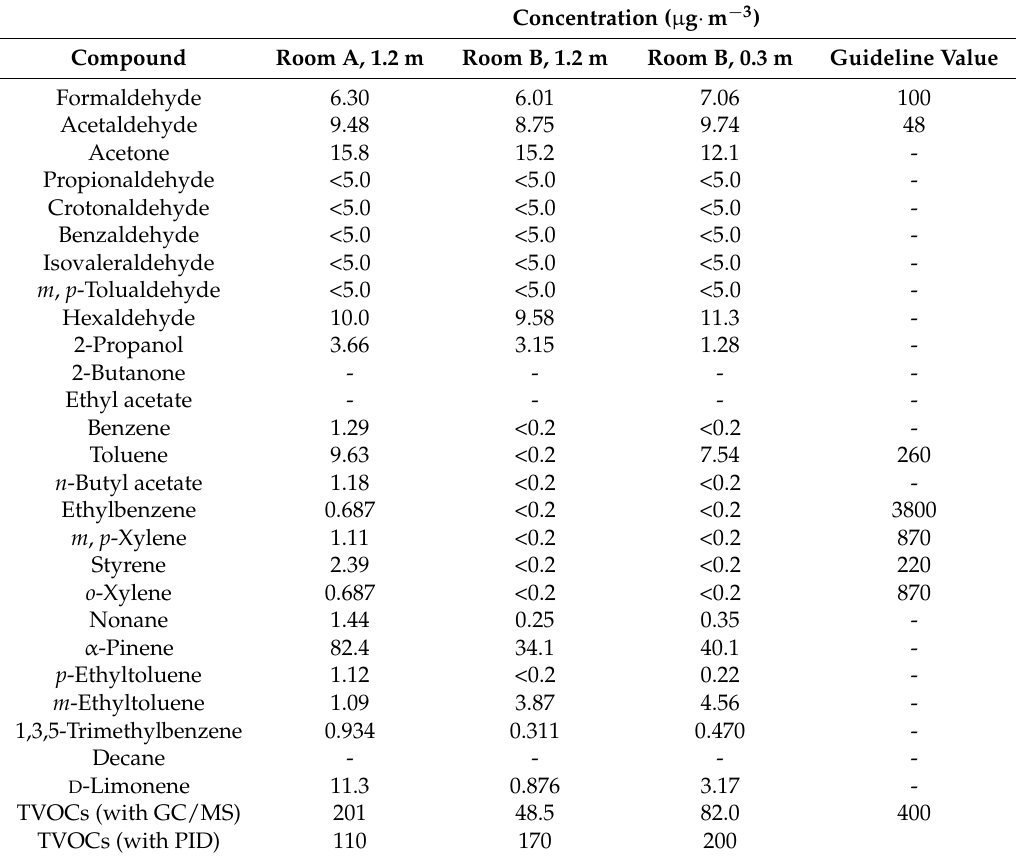
Table 4. Volatile organic compound and carbonyl compound concentrations ( µ g ¨ m ´ 3 ) in air inside the daycare center after three months of